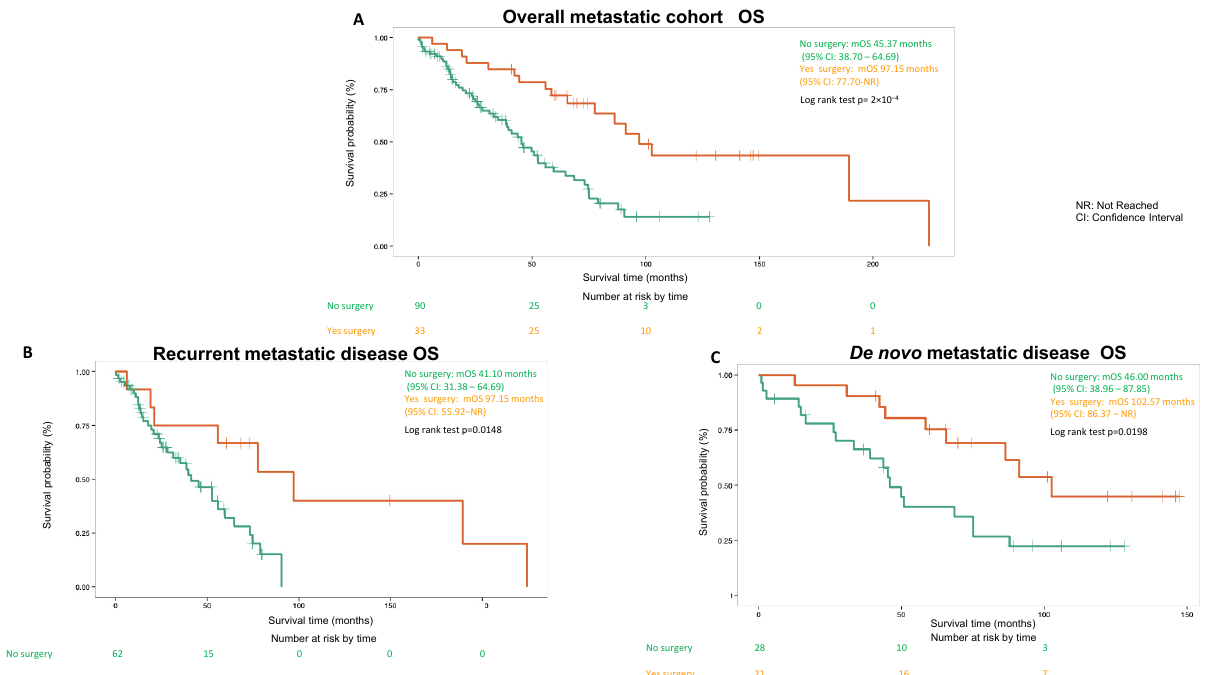
Figure 2—Clinical outcomes (OS) comparing metastatic GIST patients who underwent surgery versus no surgery